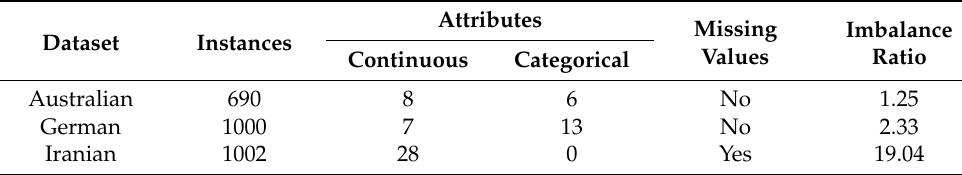
Table 2. Description of the datasets